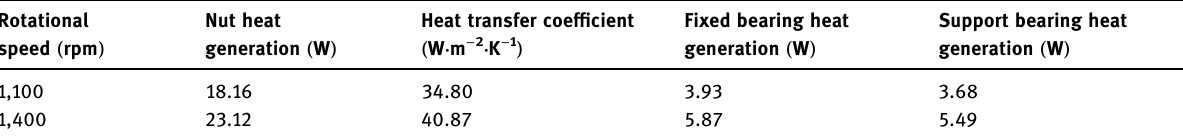
Table 2: Thermal parameters of ball screws under di ff erent rotational speeds Rotational speed ( rpm )